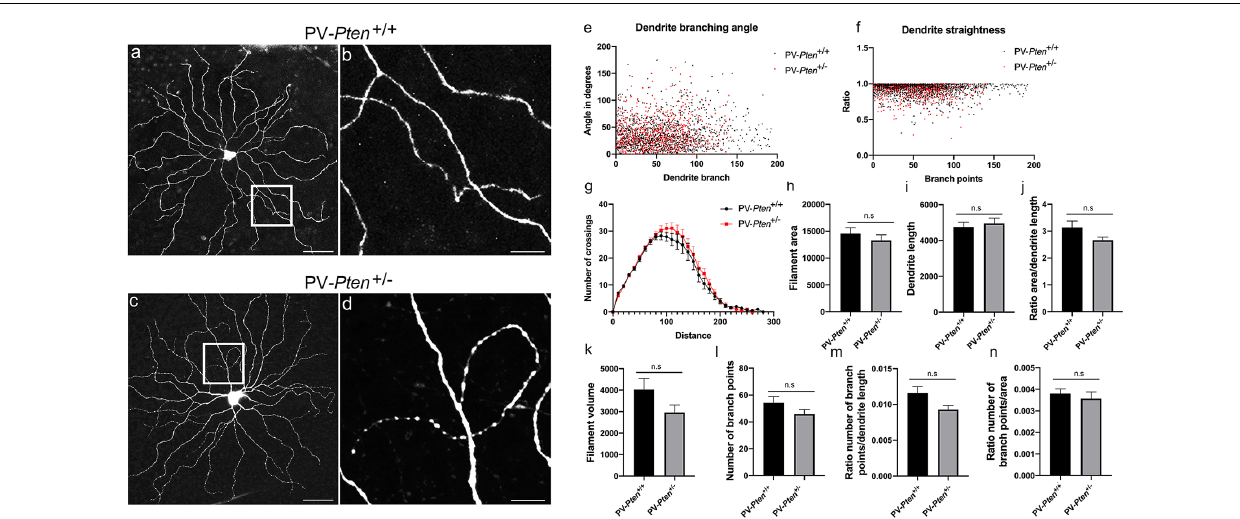
FIGURE 4 | Morphology of ON α -RGCs in PV- Pten +/+ and PV- Pten + / − retinas. (A) Neurobiotin-filled ON α -RGC in a PV- Pten +/+ retina showing the dendritic architecture. (B) High magnification (box area from A ) of dendrites showing little overlap. (C) Neurobiotin-filled ON α -RGC in the PV- Pten + / − retina showing the dendritic architecture. (D) High magnification (box area from C ) of dendrites showing a loop-forming dendrite. Comparison of dendritic morphology of ON α -RGCs in PV- Pten +/+ ( n = 14 cells) and PV- Pten + / − ( n = 11 cells) retinas. (E) Dendrite branching angle ( P > 0.05, Mann-Whitney test). (F) Dendrite straightness ( P > 0.05, Mann-Whitney test). (G) Sholl analysis ( P > 0.05 at all radii, Mann-Whitney test). (H) Filament area ( P > 0.05, Mann-Whitney test). (I) Dendrite length ( P > 0.05, Mann-Whitney test). (J) Ratio area to dendrite length ( P > 0.05, Mann-Whitney test). (K) Volume ( P > 0.05, Mann-Whitney test). (L) Branch points ( P > 0.05,